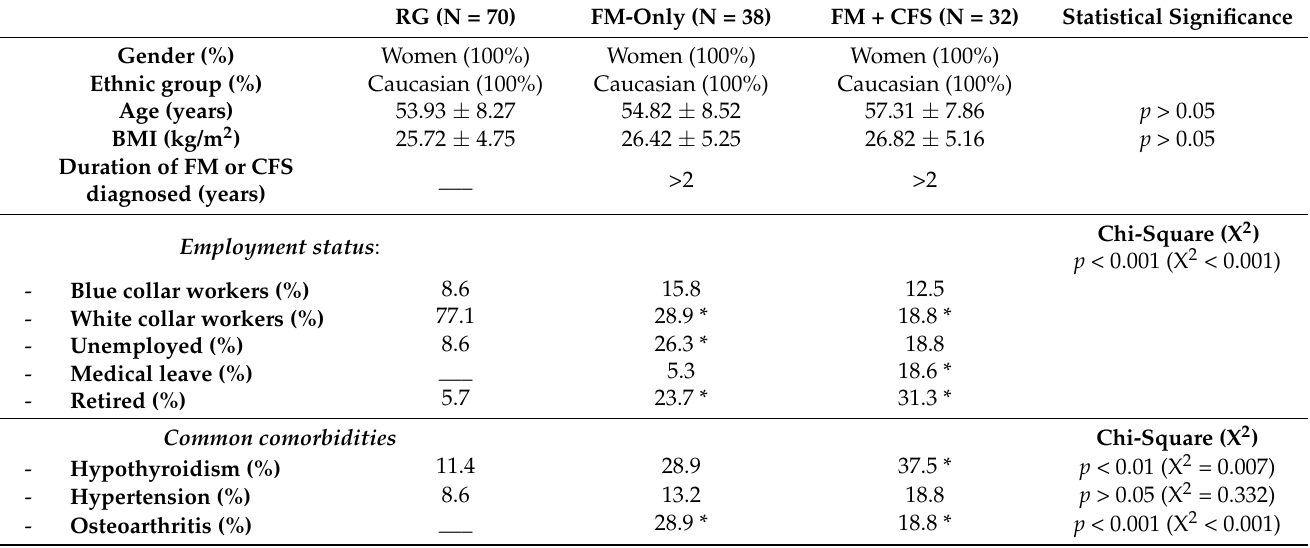
Table 1. Anthropometric characteristics, employment status, and the most common comorbidities of the